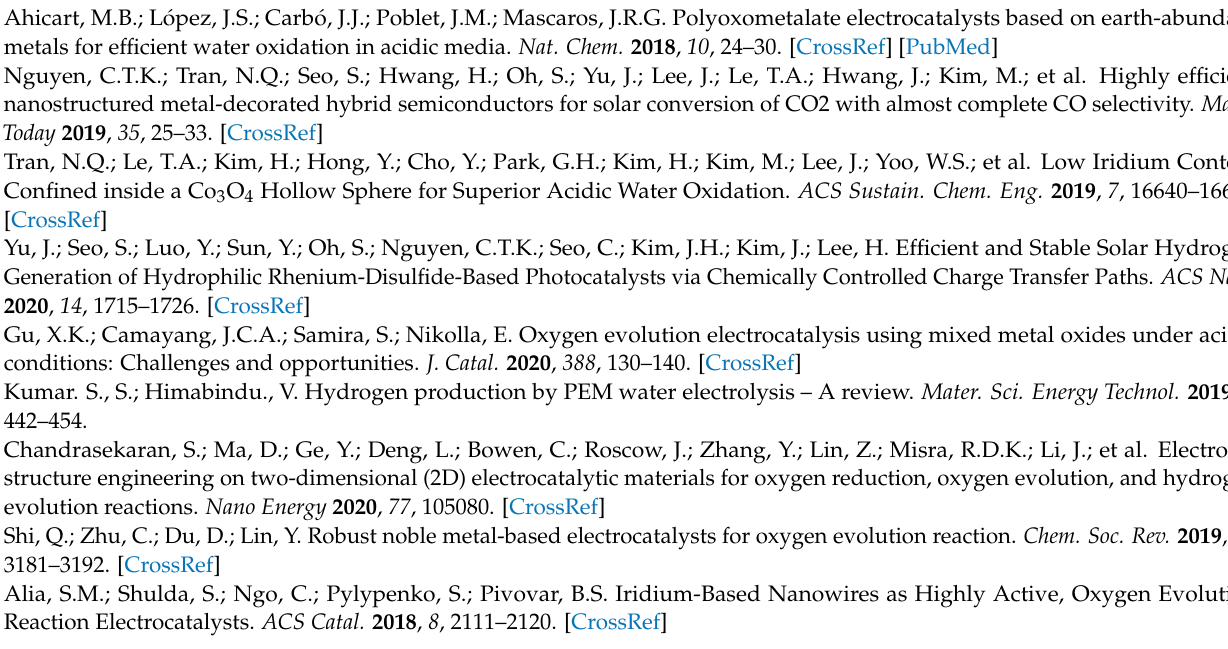
Figure S3: Comparison of LSV curves of P25, BTO, IrO2, PI–15 and BI–15 collected at the scan of 5 mV · s − 1 in 0.1 M HClO4 electrolyte, Figure S4: TEM image of BI–15 after 120 min electrocatalytic OER in 0.1 M HClO 4 , Figure S5: Acid stability test of BI–15 catalyst in 0.1 M HClO 4 electrolyte